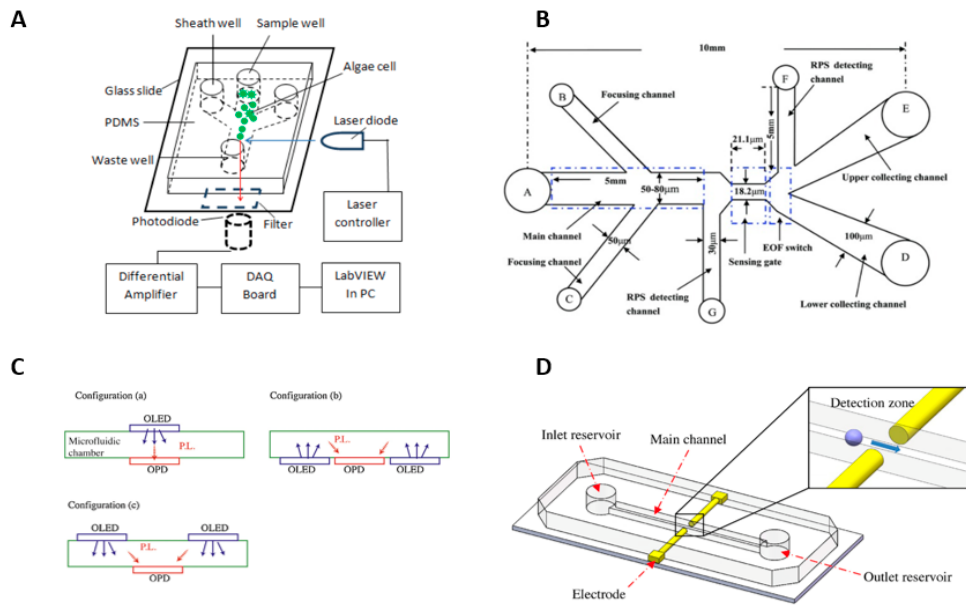
Figure 2. Microalgae viability analysis. ( A ) The schematic diagram of the chlorophyll fluorescence detection system. Reproduced with permission from [30] J. Wang et al., “A label-free microfluidic biosensor for activity detection of single microalgae cells based on chlorophyll fluorescence”, Sensors, 2013. ( B ) A schematic diagram of the system setup of resistive pulse sensor (RPS)-based particle detection and sorting [34] Y. Song et al., “Automatic particle detection and sorting in an electrokinetic microfluidic chip”, Electrophoresis, 2013. ( C ) Different OLED/OPD layouts for lab-chip fluorescence sensor. Reproduced with permission from [35] F. Lefèvre et al., “Integration of fluorescence sensors using organic optoelectronic components for microfluidic platform”, Sensors and Actuators B: Chemical, 2015. ( D ) Schematic diagram of the chip structure and the capacitive detection zone. Reproduced with permission from [32] Y. Song et al., “Capacitive detection of living microalgae in a microfluidic chip”, Sensors and Actuators B: Chemical, 2014.